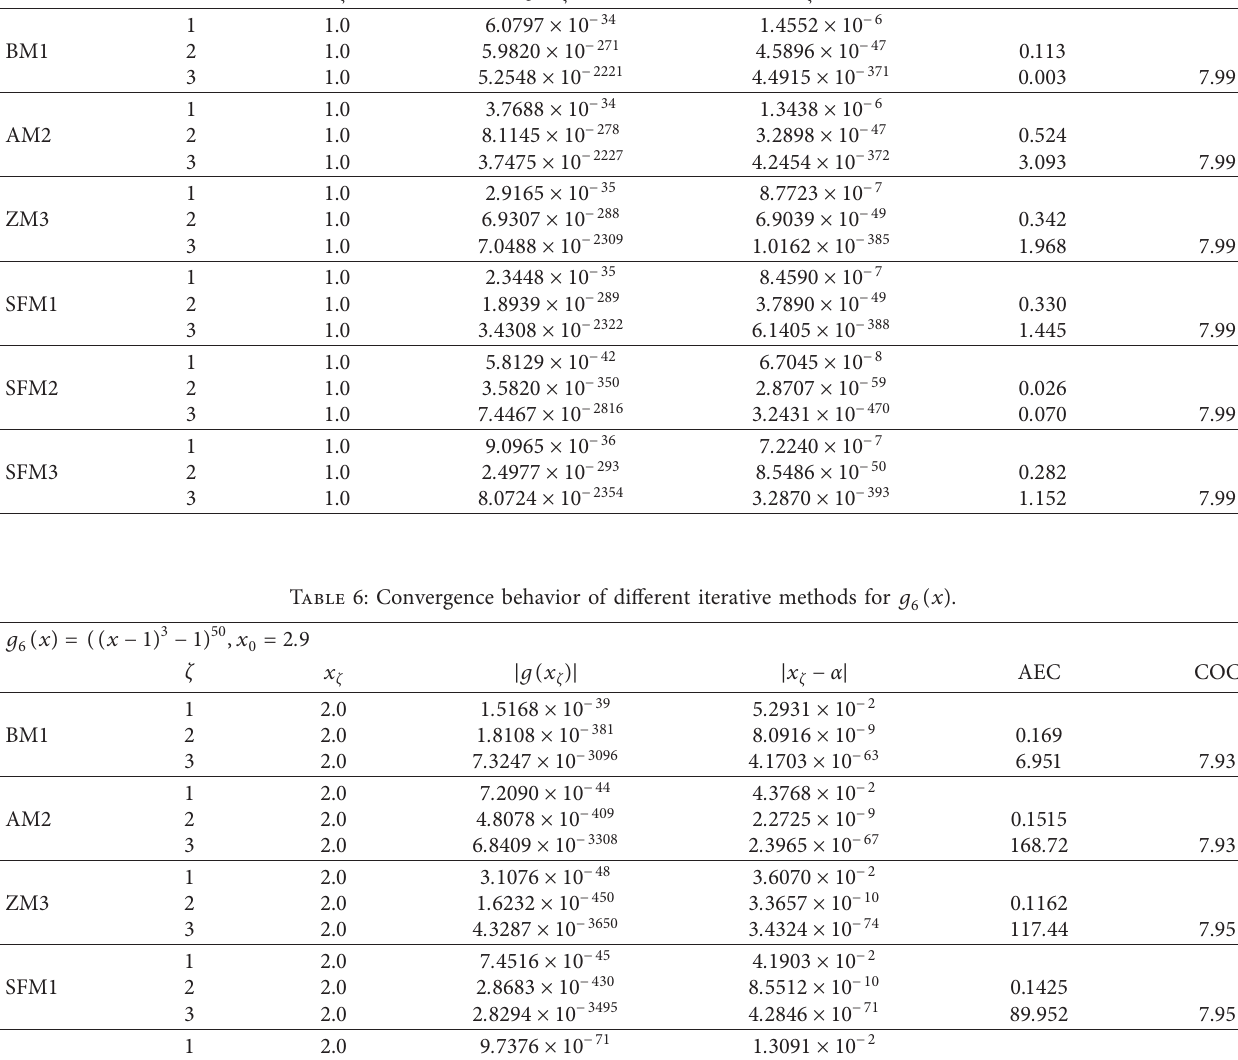
Table 5: Convergence behavior of different iterative methods for g